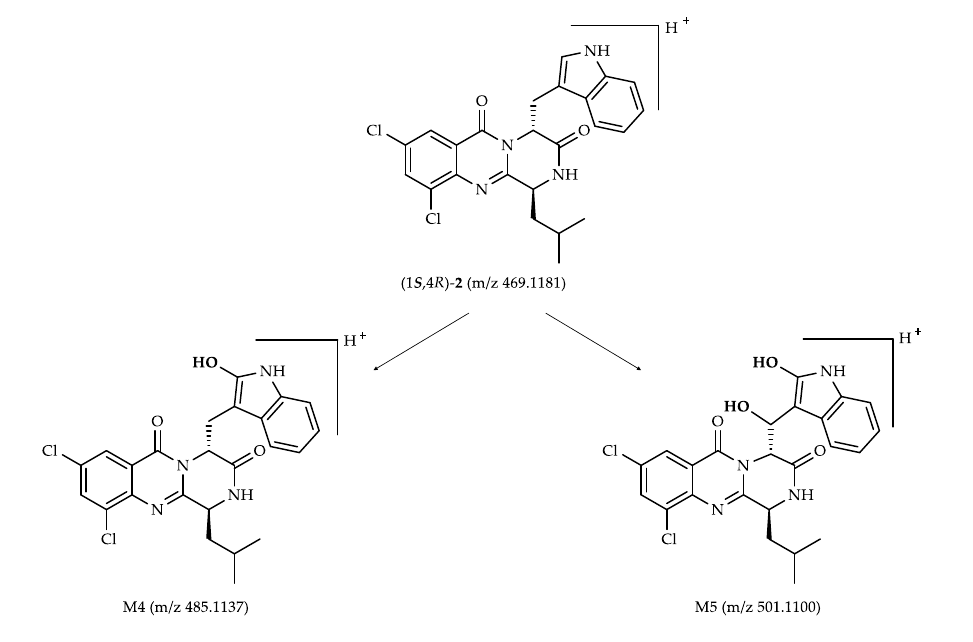
Figure 4. Inferred in vitro metabolites of 2 . Figure 4. Inferred In vitro metabolites of 2